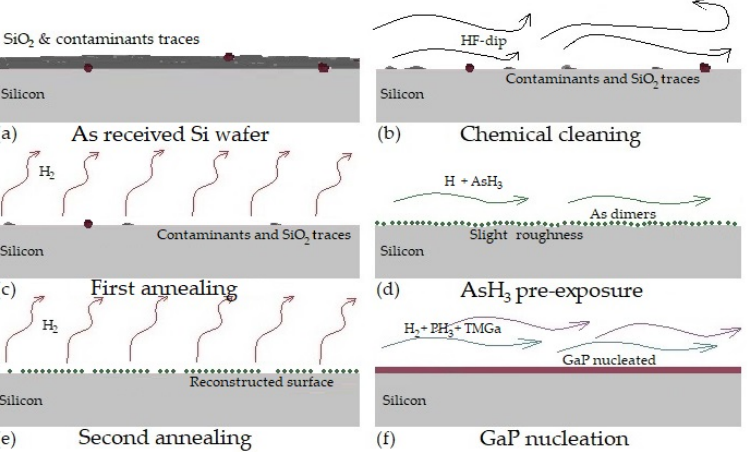
Figure 2. Different steps of the routine designed in this research: ( a ) Si wafer as received with native oxide and contaminants; ( b ) Chemical cleaning with a HF-dip; ( c ) Annealing in the reactor chamber under H 2 ; ( d ) AsH 3 pre-exposure; ( e ) Second annealing under H 2 ; ( f ) GaP nucleation.